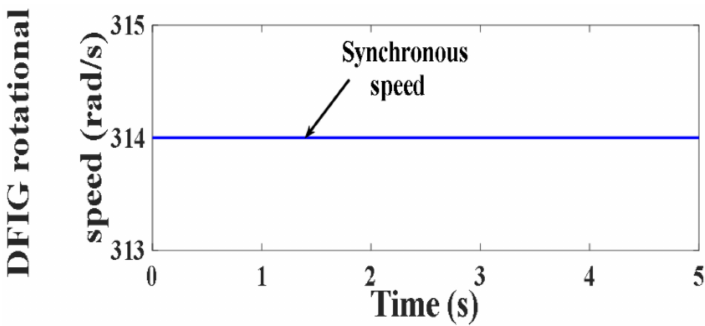
Figure 83. Prime mover operating speeds (rad/s).